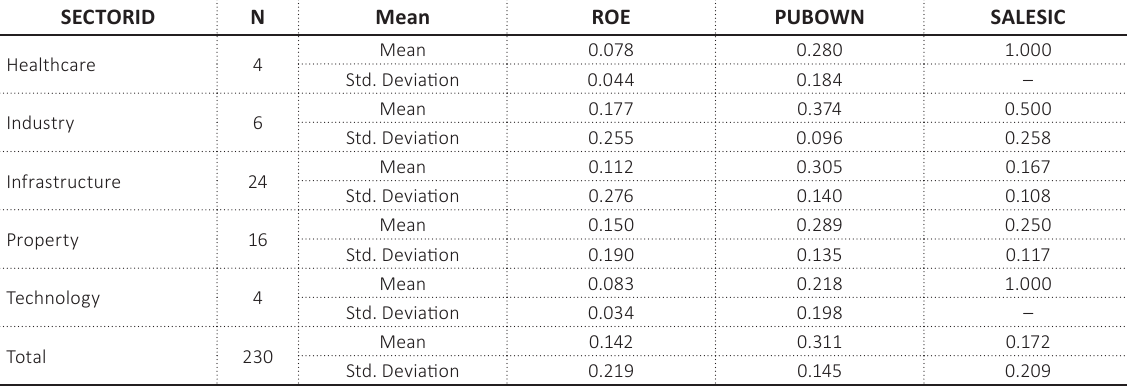
Table 5 (cont.). Descriptive statistics (ROE, PUBOWN, SALESIC) by